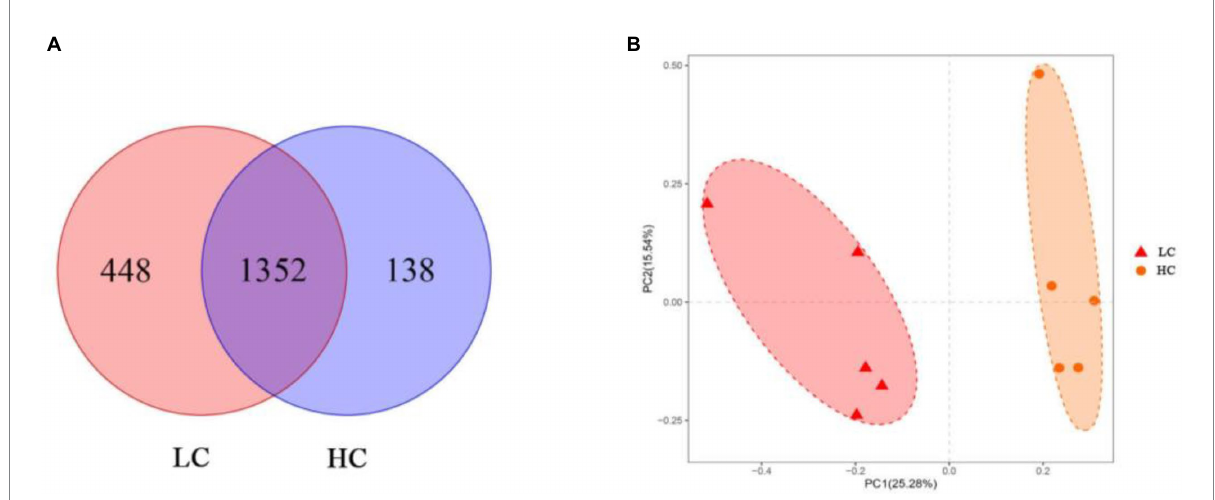
FIGURE 1 Differences in ruminal microbial communities and operational taxonomic units (OTUs) of yaks fed low concentrate (LC) and high concentrate diets (HC). Venn diagrams (A) show the specific and shared OTU between the two groups. Differences in rumen microflora between the two groups were calculated using weighted UniFrac distances (B) and coordinates were calculated using principal coordinate analysis